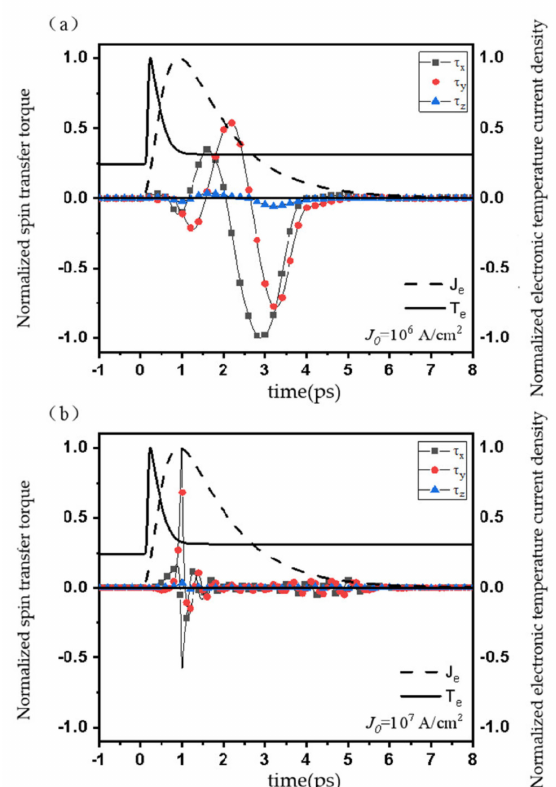
Figure 7. Time-resolved variation process of the normalized spin transfer torque in the case of sublattice magnetization flip ( a ) The injection current density is 10 6 A/cm 2 ; ( b ) the injection current density is 10 7 A/cm 2